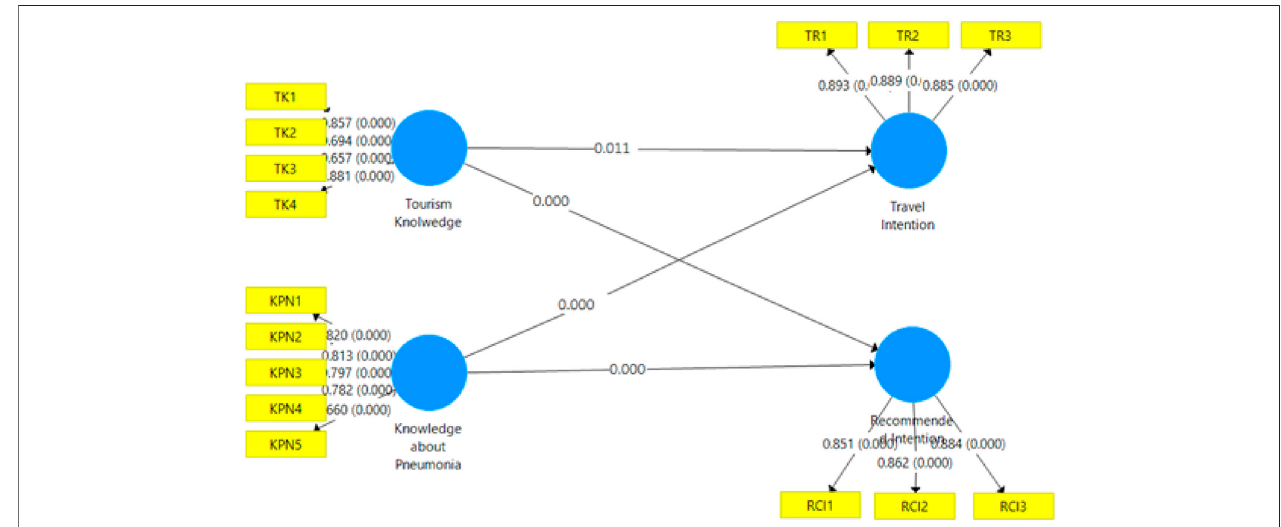
FIGURE 1 | Direct relationship (without mediation).